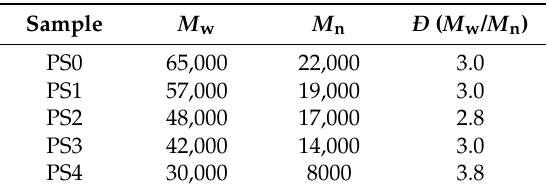
Table 2. The average molar mass ( M n ), average molecular weight ( M w ), and dispersity ( Ð ) of the PS0–4 samples.